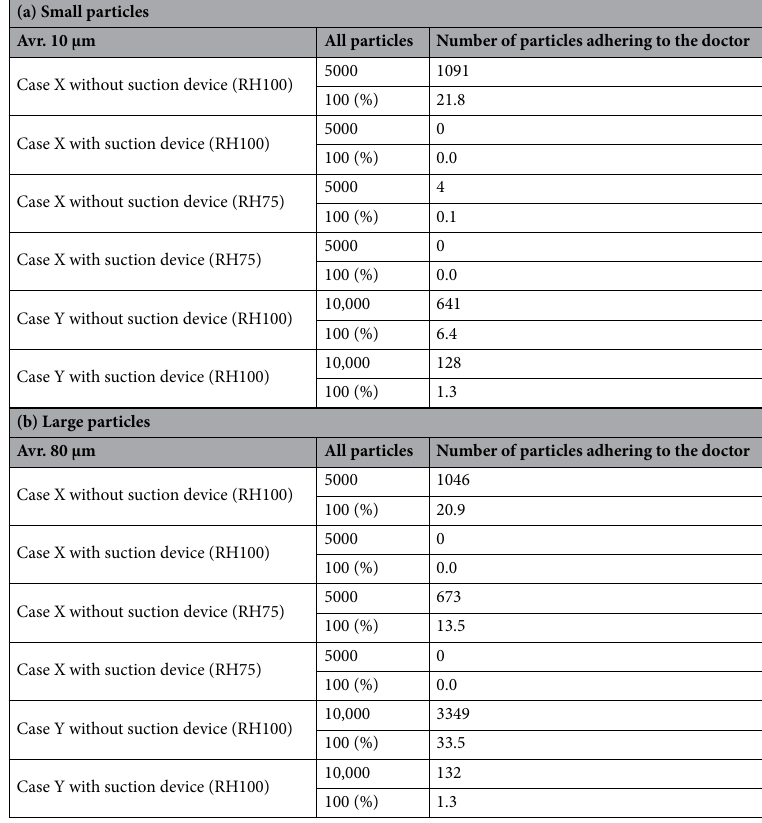
Table 3. Number (a) small and (b) large particles deposited on the physician in the presence and absence of a suction device at 15 cm from the patient’s mouth at RH75 and